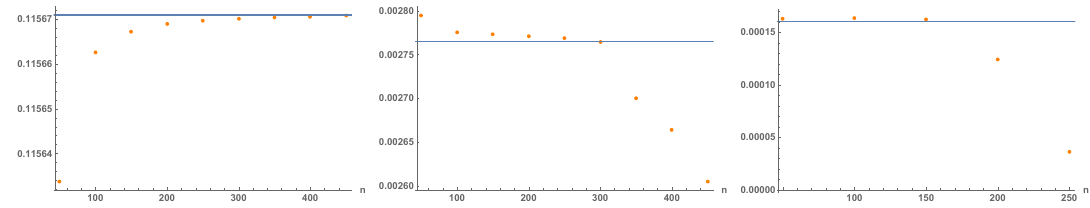
Figure 2 . Plots for the coe(cid:14)cient of (cid:22) 3 ; (cid:22) 5 ; (cid:22) 7 from the series expansion with Pad(cid:19)e approximation, as one increases the truncation